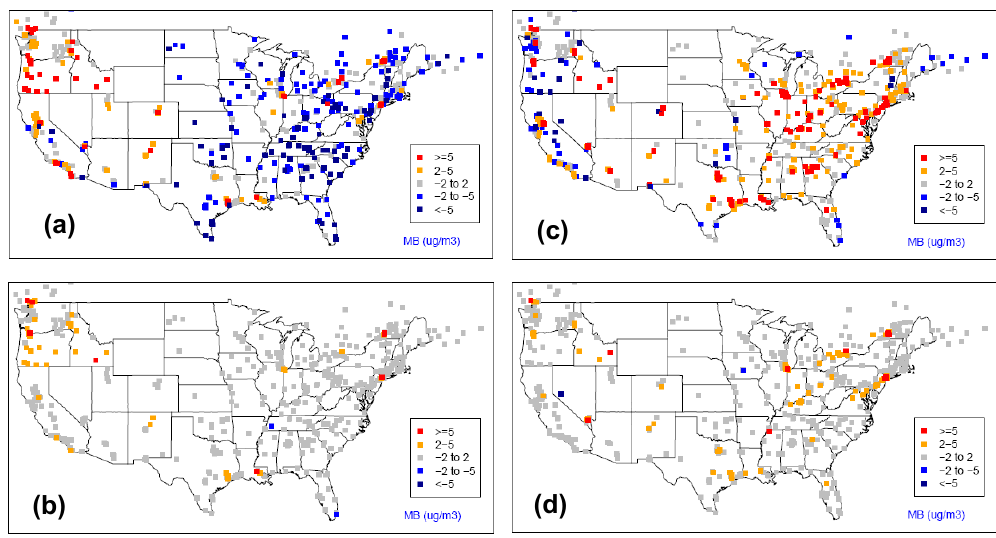
Fig. 8. Mean Bias (MB, µg/m 3 ) at each location within the continental US Domain: (a) raw model during warm season, (b) KF bias-adjustment during warm season, (c) raw model during cool season, and (d) KF bias-adjustment during cool season.